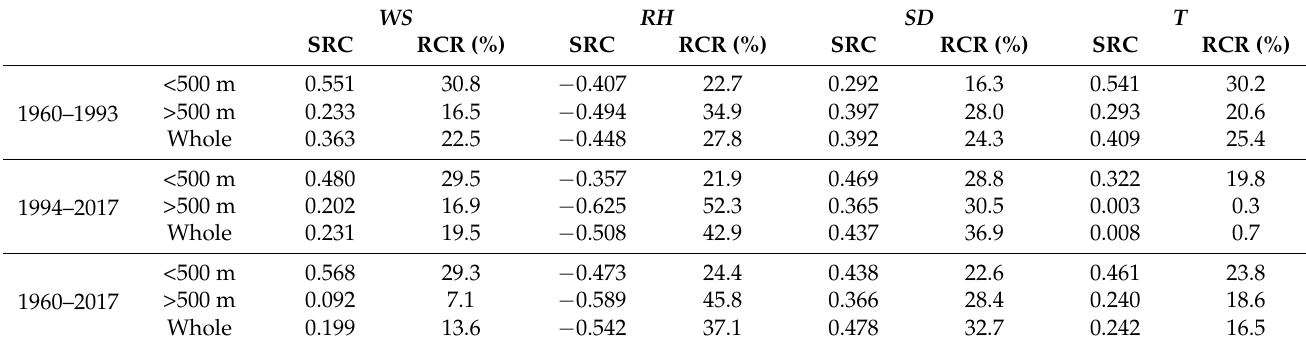
Figure 5. Correlations between the ET 0 trends and altitude. Table 2. The standard regression coefficient (SRC) and relative contribution rate (RCR) to ET 0 of the climatic